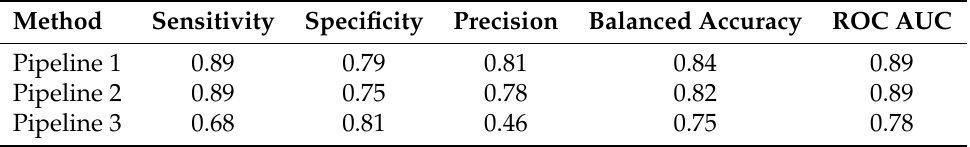
Table 2. Evaluation metrics obtained by the application of Pipelines 1, 2, and 3 on the synthetic radiomic dataset. The sensitivity, specificity, precision, balanced accuracy, and ROC AUC scores obtained on the test sets are reported for each